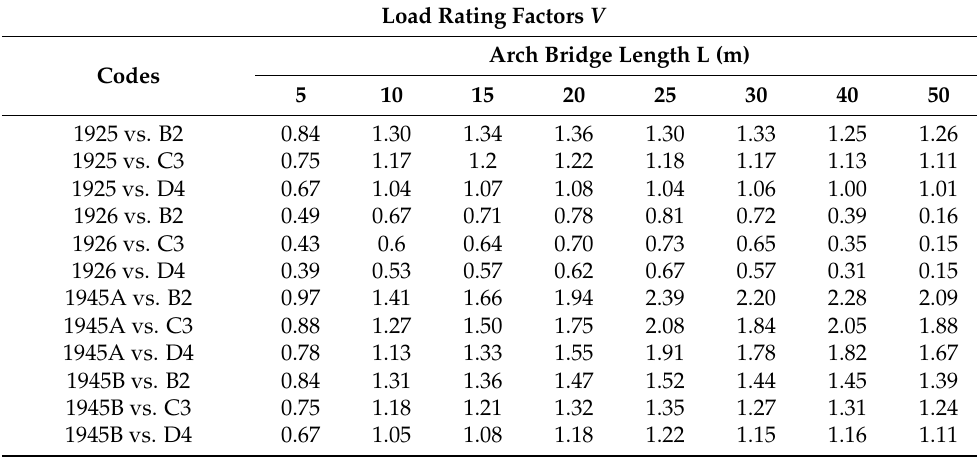
Table 3. Load Rating Factors V for the 1925, 1926, 1945A, and 1945B design loads, and the B2, C3, and D4 lines.